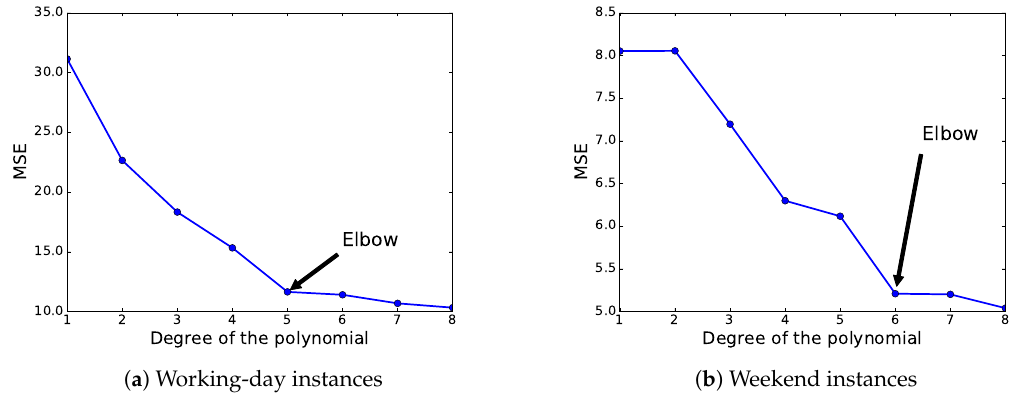
Figure 8. Polynomial fitting results (Mean Squared Error, MSE) by using different polynomial degrees.